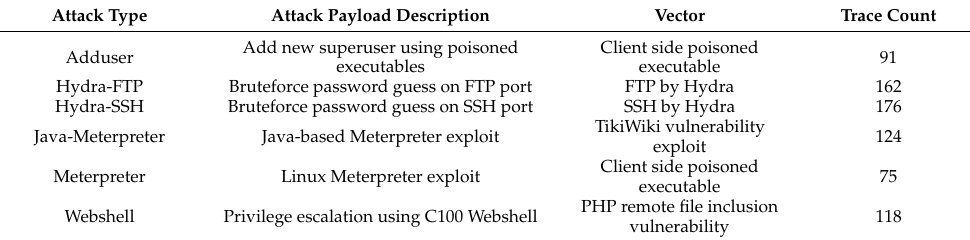
Table 10. Attack vectors used to generate the ADFA-LD attack